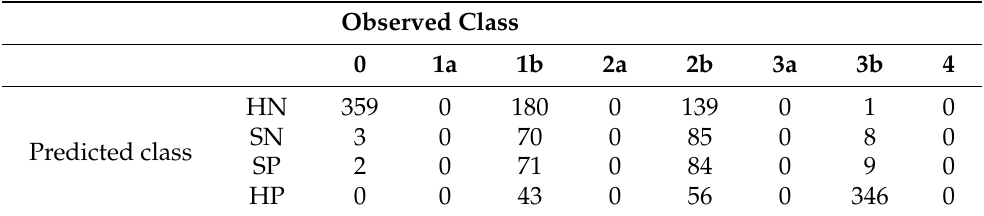
Table 16. Confusion matrix for the validation set and the SVM model. Two-class